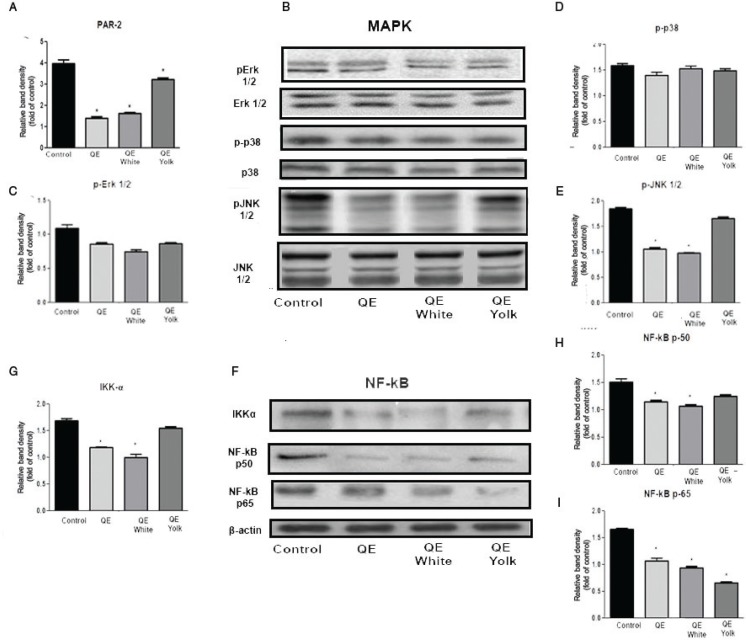
The effect of QE on the PAR-2-mediated MAPK and NF-kB cell signaling pathways of HMC-1 cells. (a) mRNA fold induction of PAR-2. (b) Western blotting of MAPK signaling. MAPK fold activation data analysis: (c) pERK1/2, (d) p-p38 and (e) p-JNK1/2. (f) Western blotting of NF-kB signaling. NF-kB fold activation data analysis: (g) IKK-α, (h) NF-kB p50, and (i) NF-kB p65. Results are expressed as mean ± SEM. *p < 0.05 as compared to the control group.